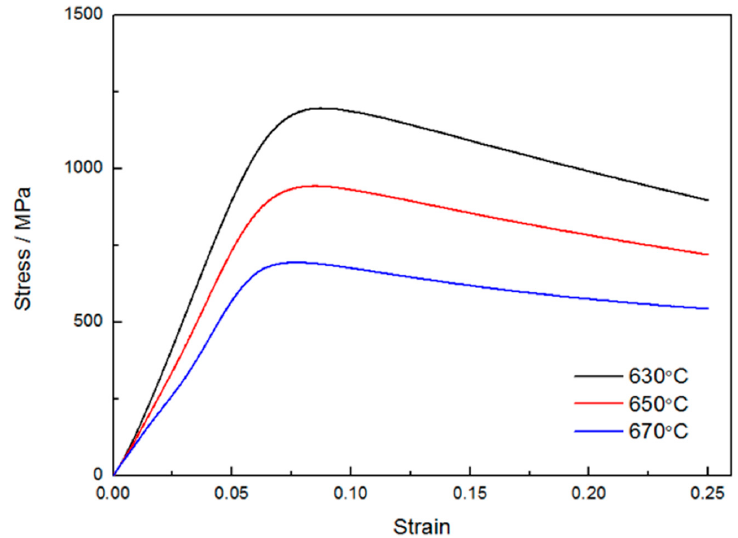
Figure 6. Stress-strain curve of H13 steel at 630 °C, 650 °C and 670 °C.